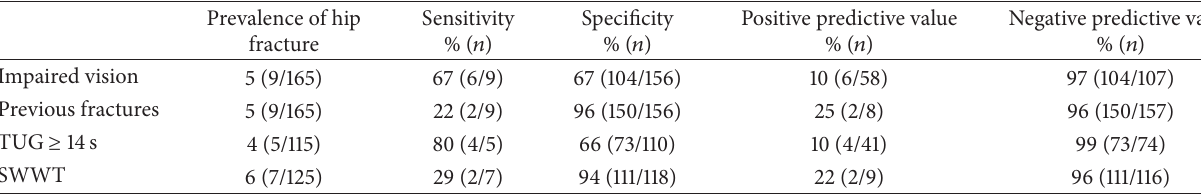
Table 4: Accuracy of the fracture